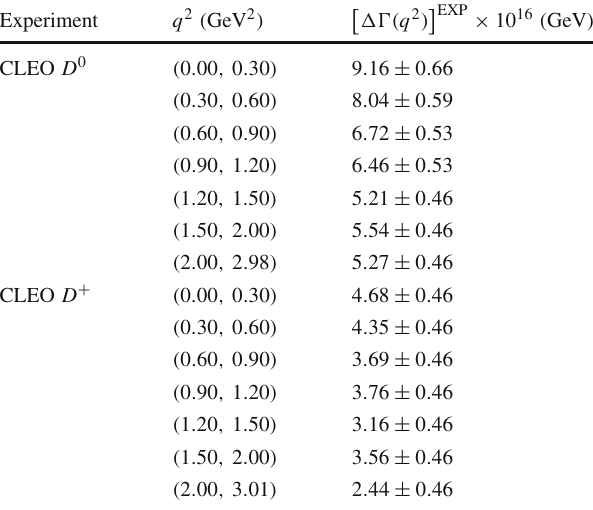
Table 3 Values of the partial decay rates transition in the q 2 -bins measured by CLEO [7], given separately for the D 0 → π − (cid:3)ν and D + → π 0 (cid:3)ν channels Experiment q 2 ( GeV 2 )